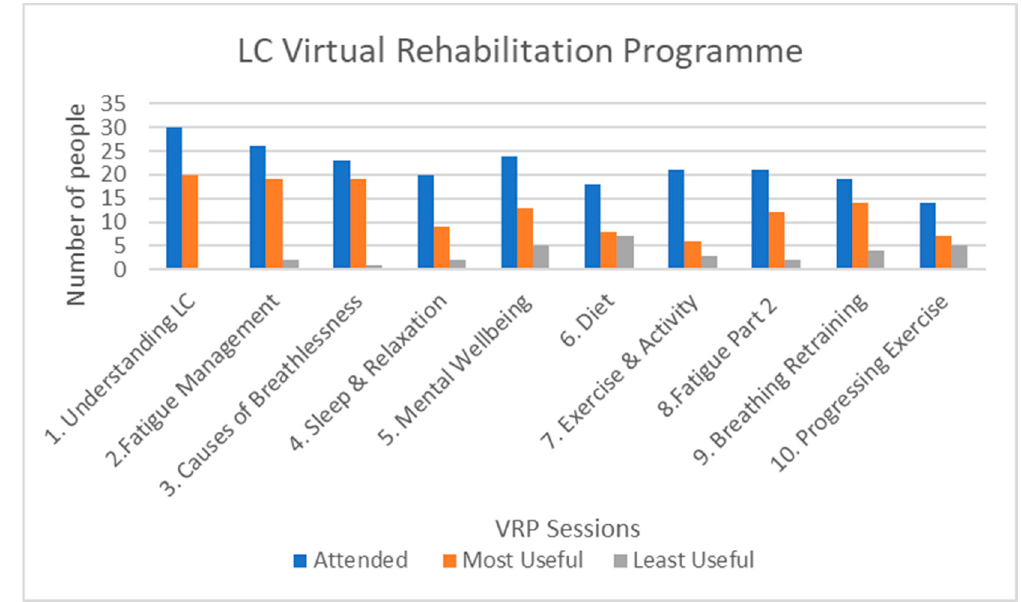
Figure 1. Sessions attended: Most and Least useful session(s).